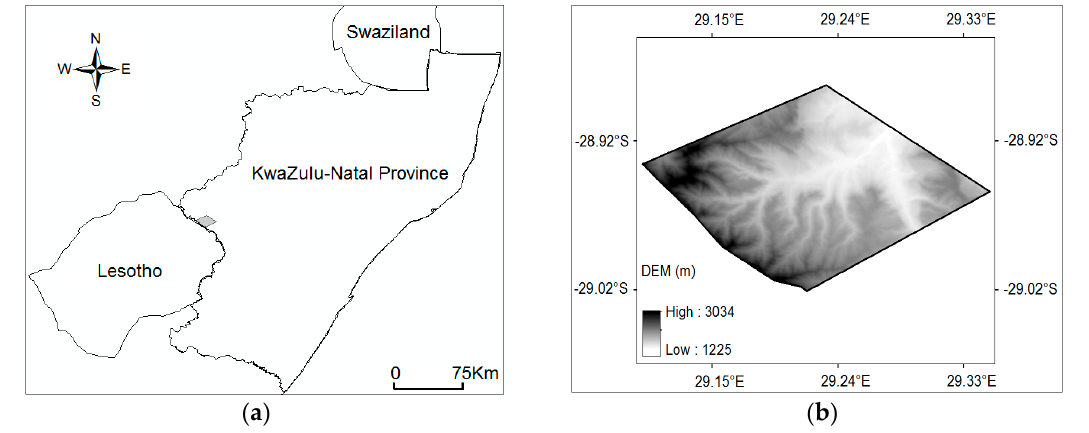
Figure 1. Location of the study area ( a ) and its altitudinal variations ( b )